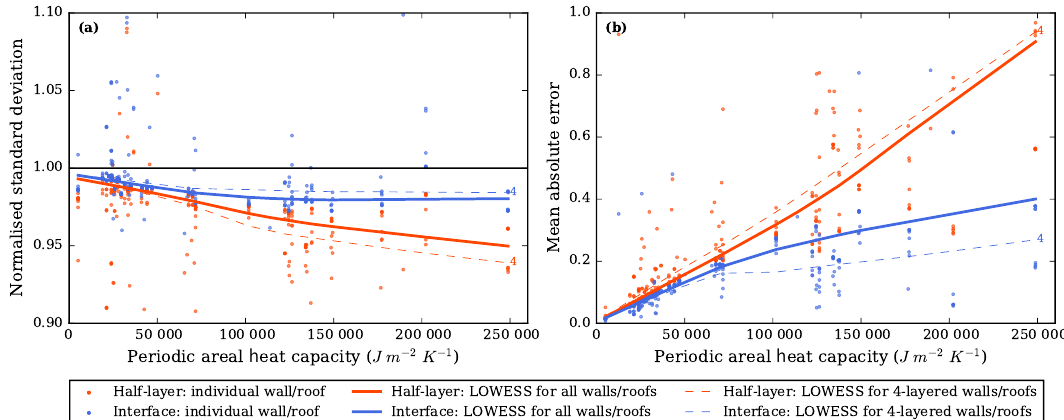
Figure 3. Heat storage errors of the half-layer and the proposed interface schemes vs. exact solution over increasing periodic areal heat capacity (or thermal mass), with lightweight framed construction on the left, and heavyweight stone/ rubble construction on the right. For both (a) normalised standard deviation and (b) mean absolute error, the interface scheme locally weighted linear regression (LOWESS) outperforms the half-layer scheme overall (solid lines). Differences between schemes are more pronounced for walls/roofs with large thermal mass, and those represented with fewer layers (four-layers shown